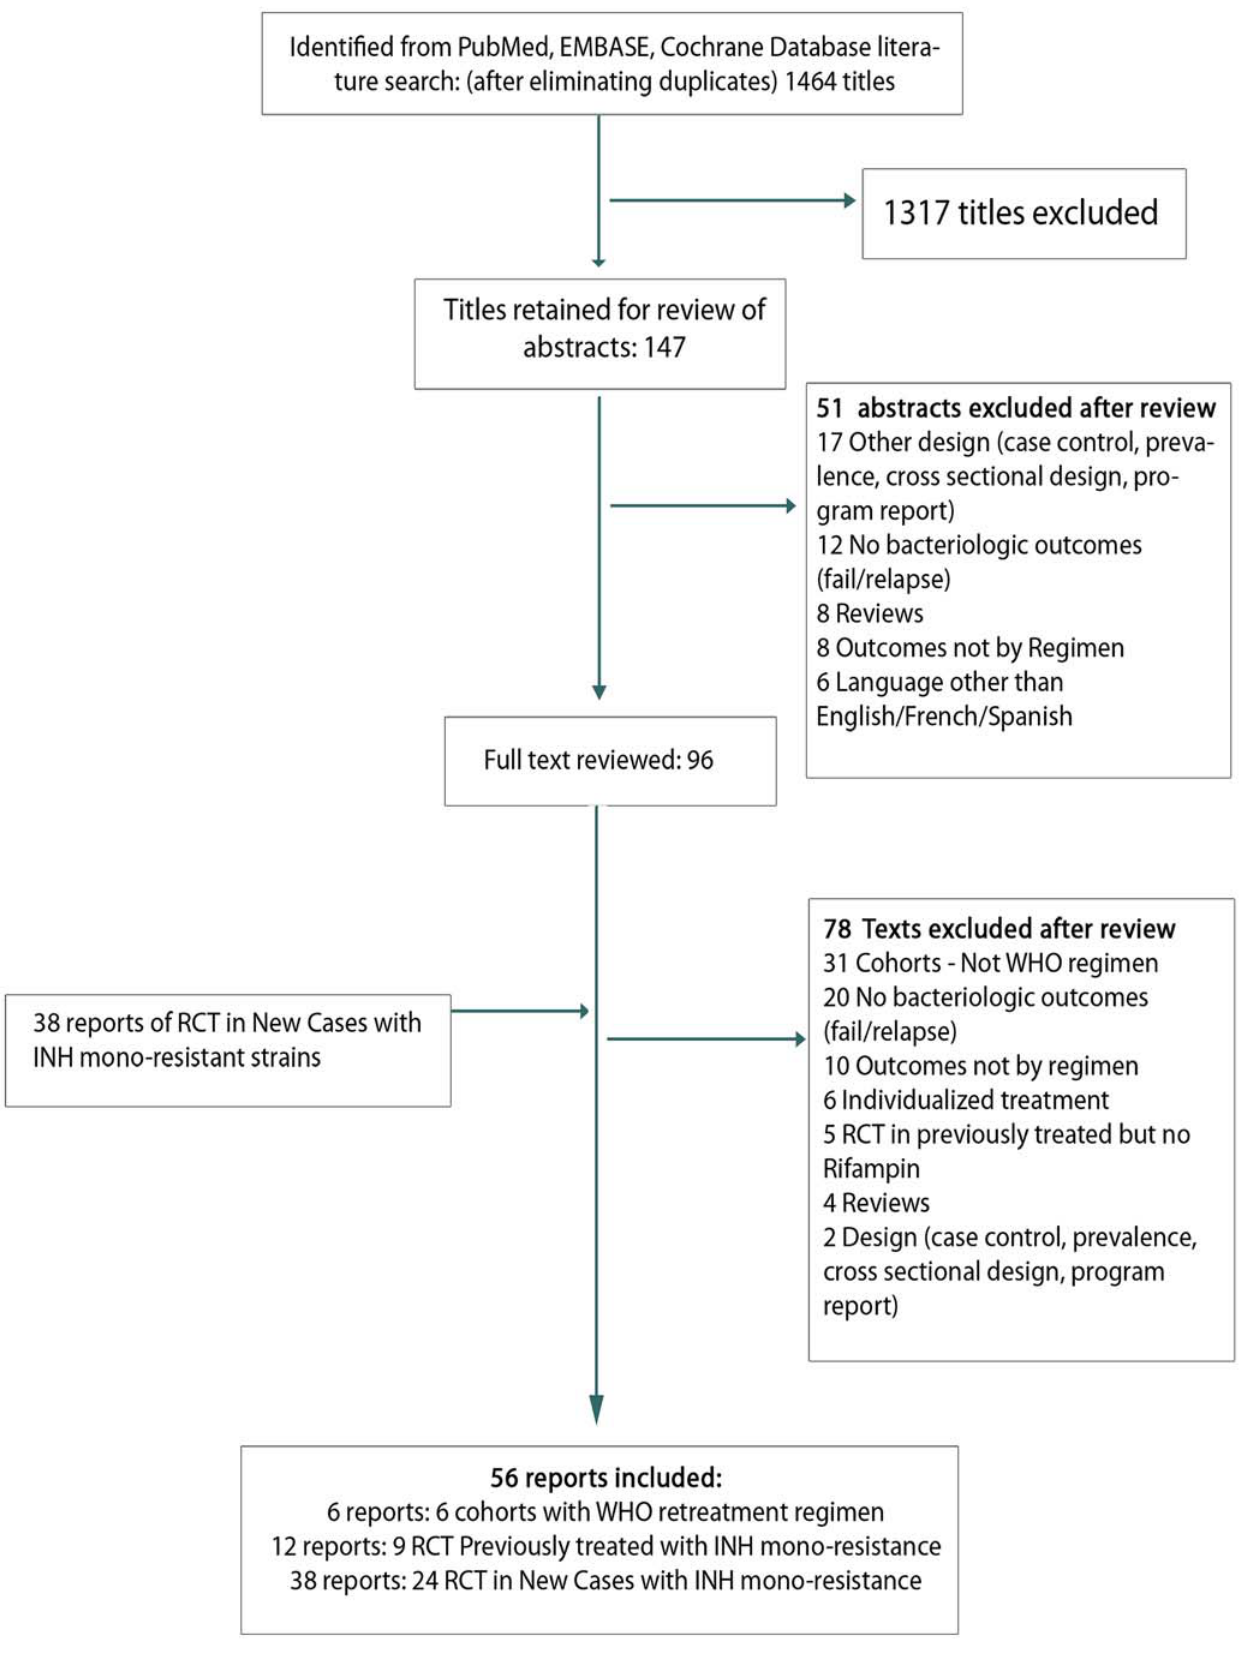
Figure 1. Summary of study review and selection.